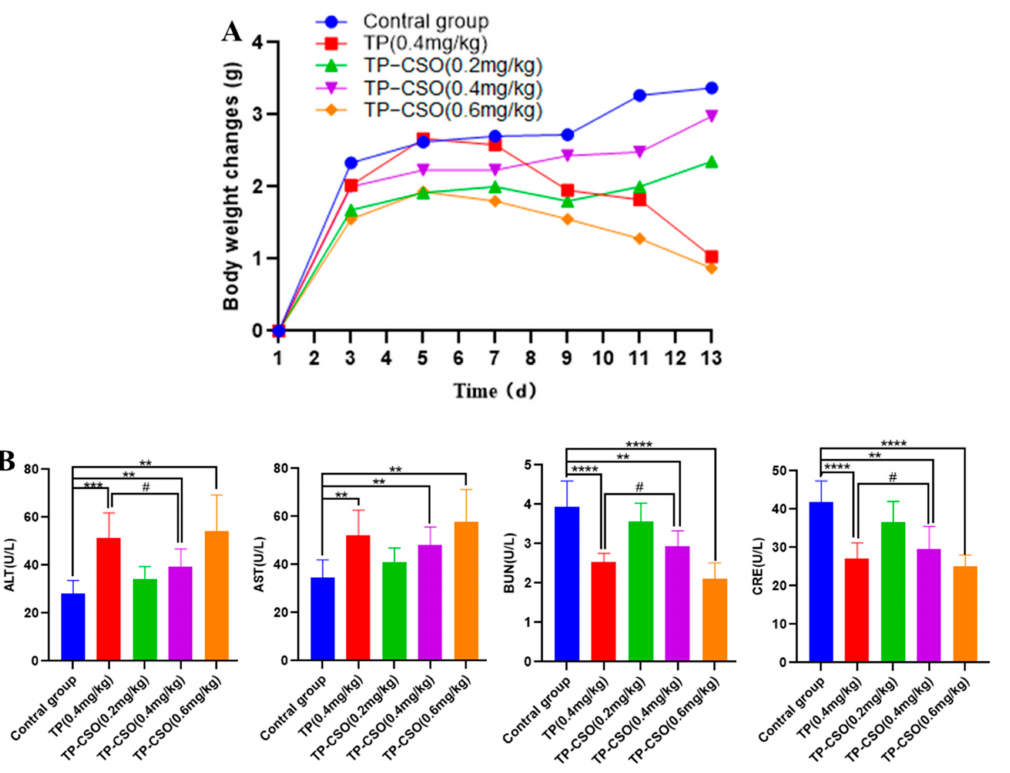
Figure 4. In vivo toxicity of TP and TP-CSO: body weight changes ( A ); biochemical parameters ( B ). ** Represents p < 0.01, *** represents p < 0.001, **** represents p < 0.0001, vs. control group; # represents p < 0.0001, TP-CSO (0.4 mg/kg) vs. TP group (0.4 mg/kg) (n = 6). Different degrees of liver and kidney injury are indicated by the changes in serum ALT, AST, BUN and CRE levels [24]. The ALT and AST levels in the TP group and the high-dose TP-CSO group were obviously higher than those in other groups, which indicated the